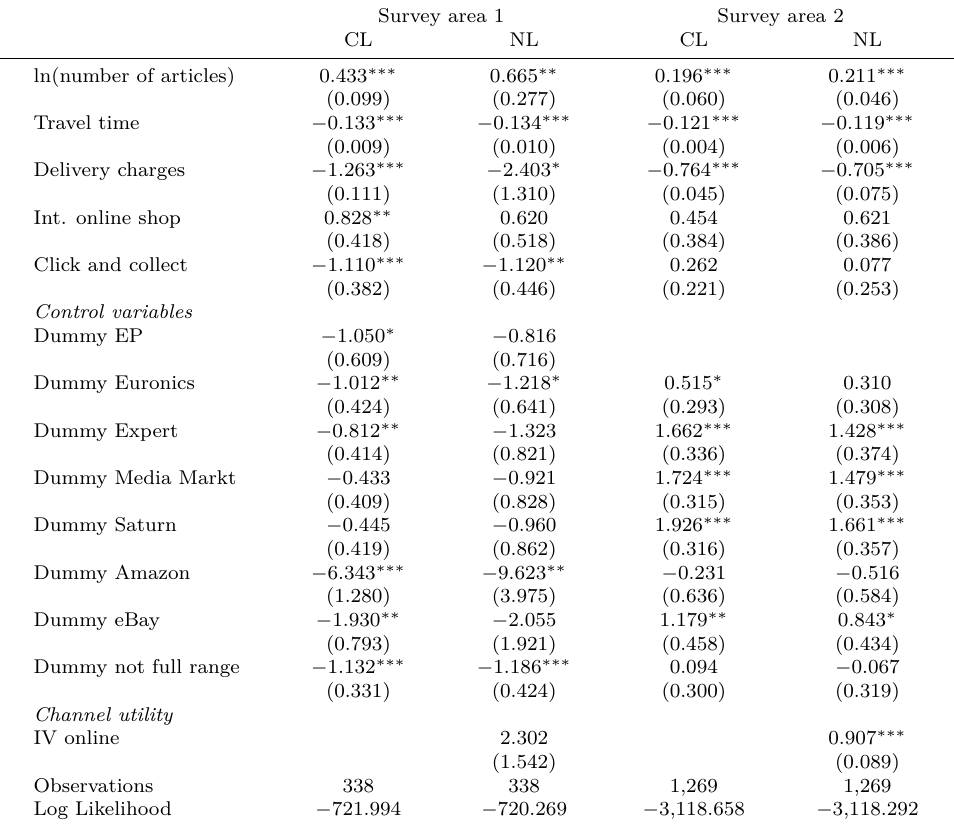
Table 8: Discrete Choice analysis for consumer electronics stores by survey area – Dependent variable: Store choice probability Survey area